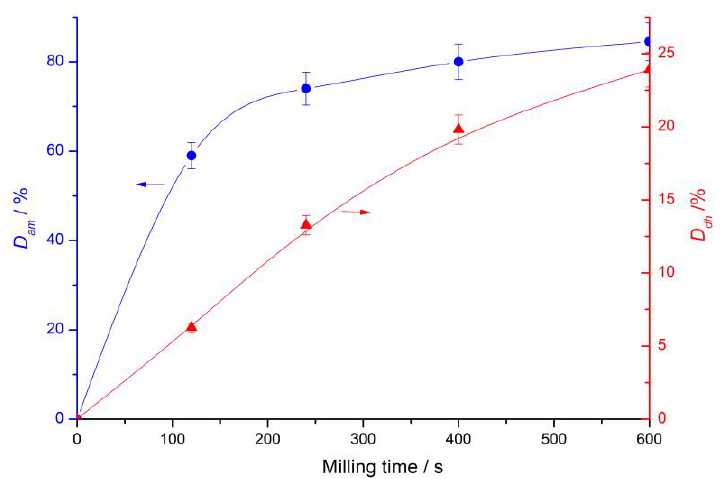
Figure 3. Degree of amorphisation ( D am ) and degree of dehydroxylation ( D dh ) of antigorite as a function of milling time (moderate mechanical activation in air).